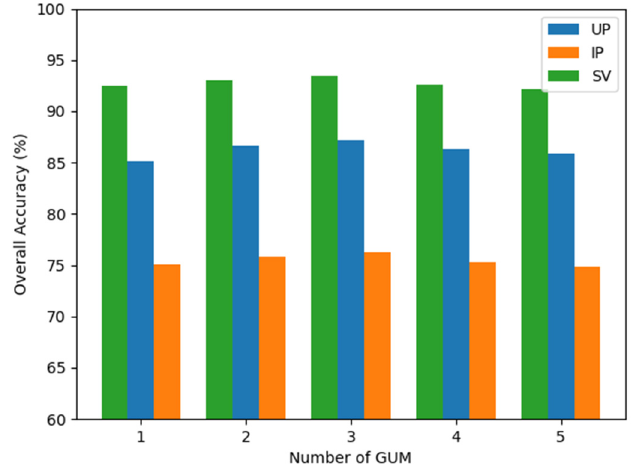
Figure 13. OAs obtained by GDFSL with various numbers of GUM on three HSI datasets.